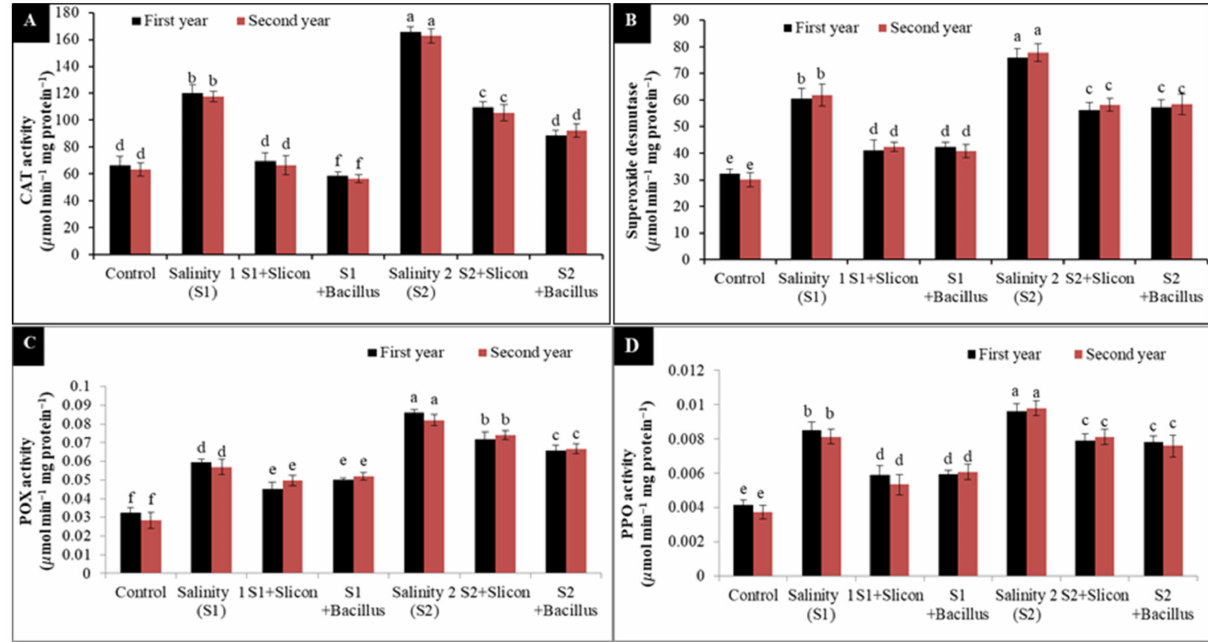
Figure 2. Effect of Si (potassium silicate at 2.7 mmol L − 1 ) and B. thuringiensis on the activity of CAT ( A ), SOD ( B ), POX ( C ), and PPO ( D ) in lettuce plants under salinity during two seasons (2019/2020 and 2020/2021). Different letters on the columns show significant differences between the treatments according to ANOVA, Duncan’s multiple range test at 0.05 level. Data is the mean ( ± SE) of tree replicates. Salinity 1 (S1): 4 dS m − 1 , Salinity 2 (S2): 8 dS m − 1